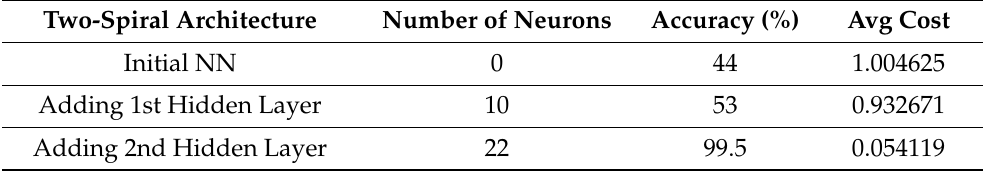
Figure 7. Testing two-spiral problem using CCG-DLNN algorithm. Table 1. Testing two-spiral problem using CCG-DLNN.